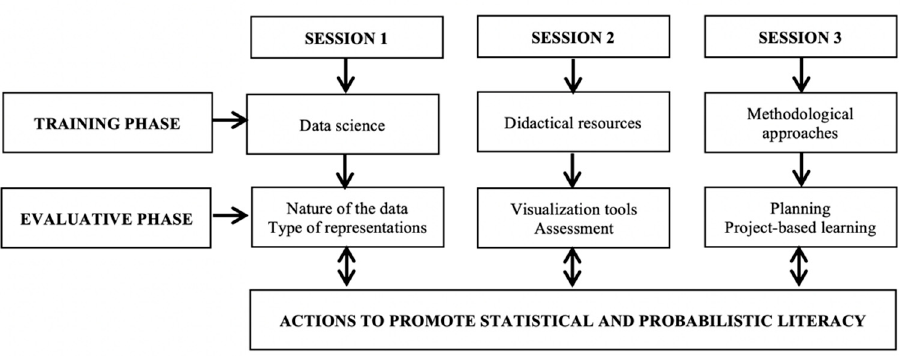
Figure 3. Structure of the activities and organization of the topics covered in each session.